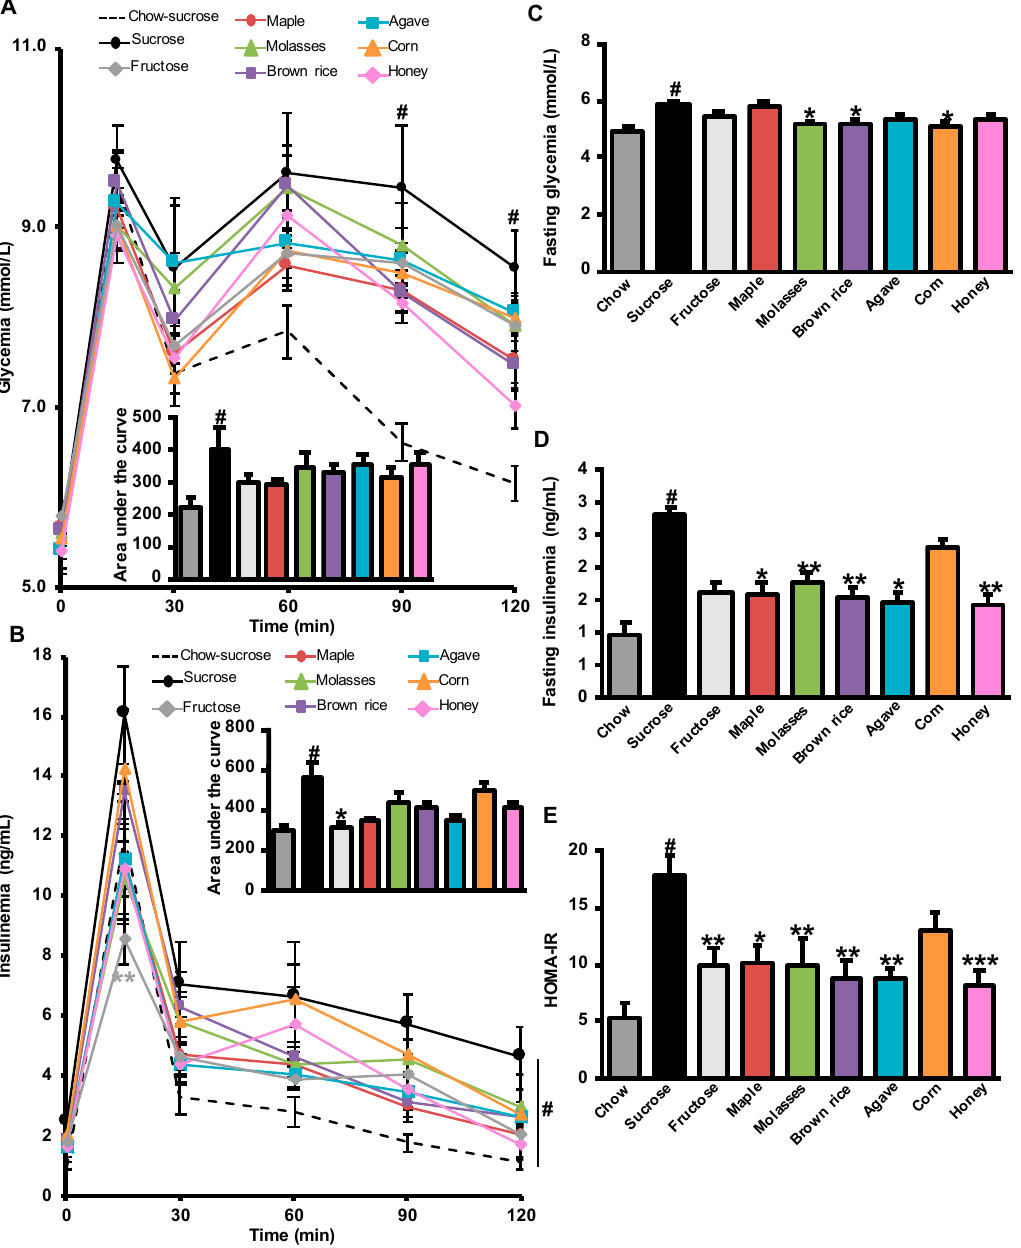
Figure 2. Fructose and natural sweeteners limit insulin resistance. Glucose and insulin homeostasis in male Wistar rats treated with refined sugars and natural sweeteners for 8 weeks. ( A ) Glycemic excursion curves during oral glucose tolerance test (OGTT) with their corresponding area under the curve of glucose. ( B ) Insulinemic excursion curves during OGTT and their corresponding area under the curve. ( C ) Fasting glycemia at sacrifice. ( D ) Fasting insulinemia at sacrifice. ( E ) Homeostatic model assessment of insulin resistance (HOMA-IR) at sacrifice. Data represent mean ± SEM, n = 10–12 rats. # p < 0.05, t -test for chow-sucrose (reference for HFHS-induced obesity) versus HFHS-sucrose. * p < 0.05, ** p < 0.01, *** p < 0.001, one-way ANOVA for HFHS fructose and natural sweeteners versus HFHS-sucrose. ** p < 0.01, two-way repeated-measures ANOVA for comparisons over the course of the OGTT in ( A , B ).